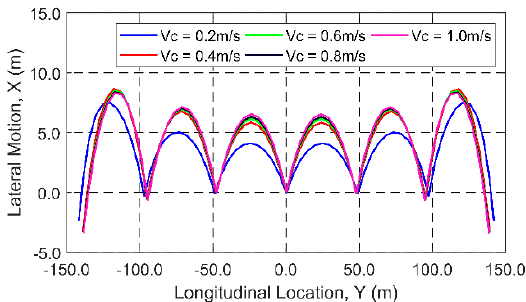
Figure 6. Envelopes of the lateral responses (Z = − 23 m) of the net assembly at different current velocities.